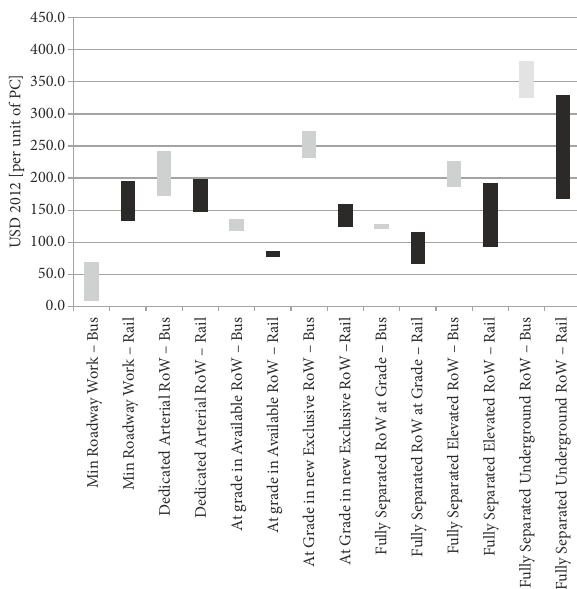
Figure 3. PC components of PT in different